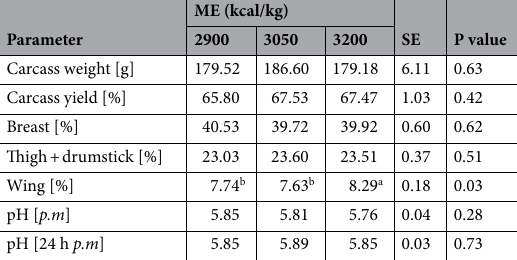
Table 5. Quail meat performance (49 days of age) and breast pH as a function of metabolizable energy levels (ME). SE: Standard error of the mean; Means followed by different letters differ from each other by Tukey’s test at 5% probability.